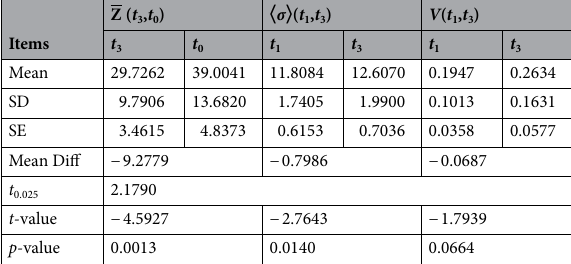
σ ( t 3 – t 1 ), V ( t 3 – t 1 (cid:31) (cid:30)